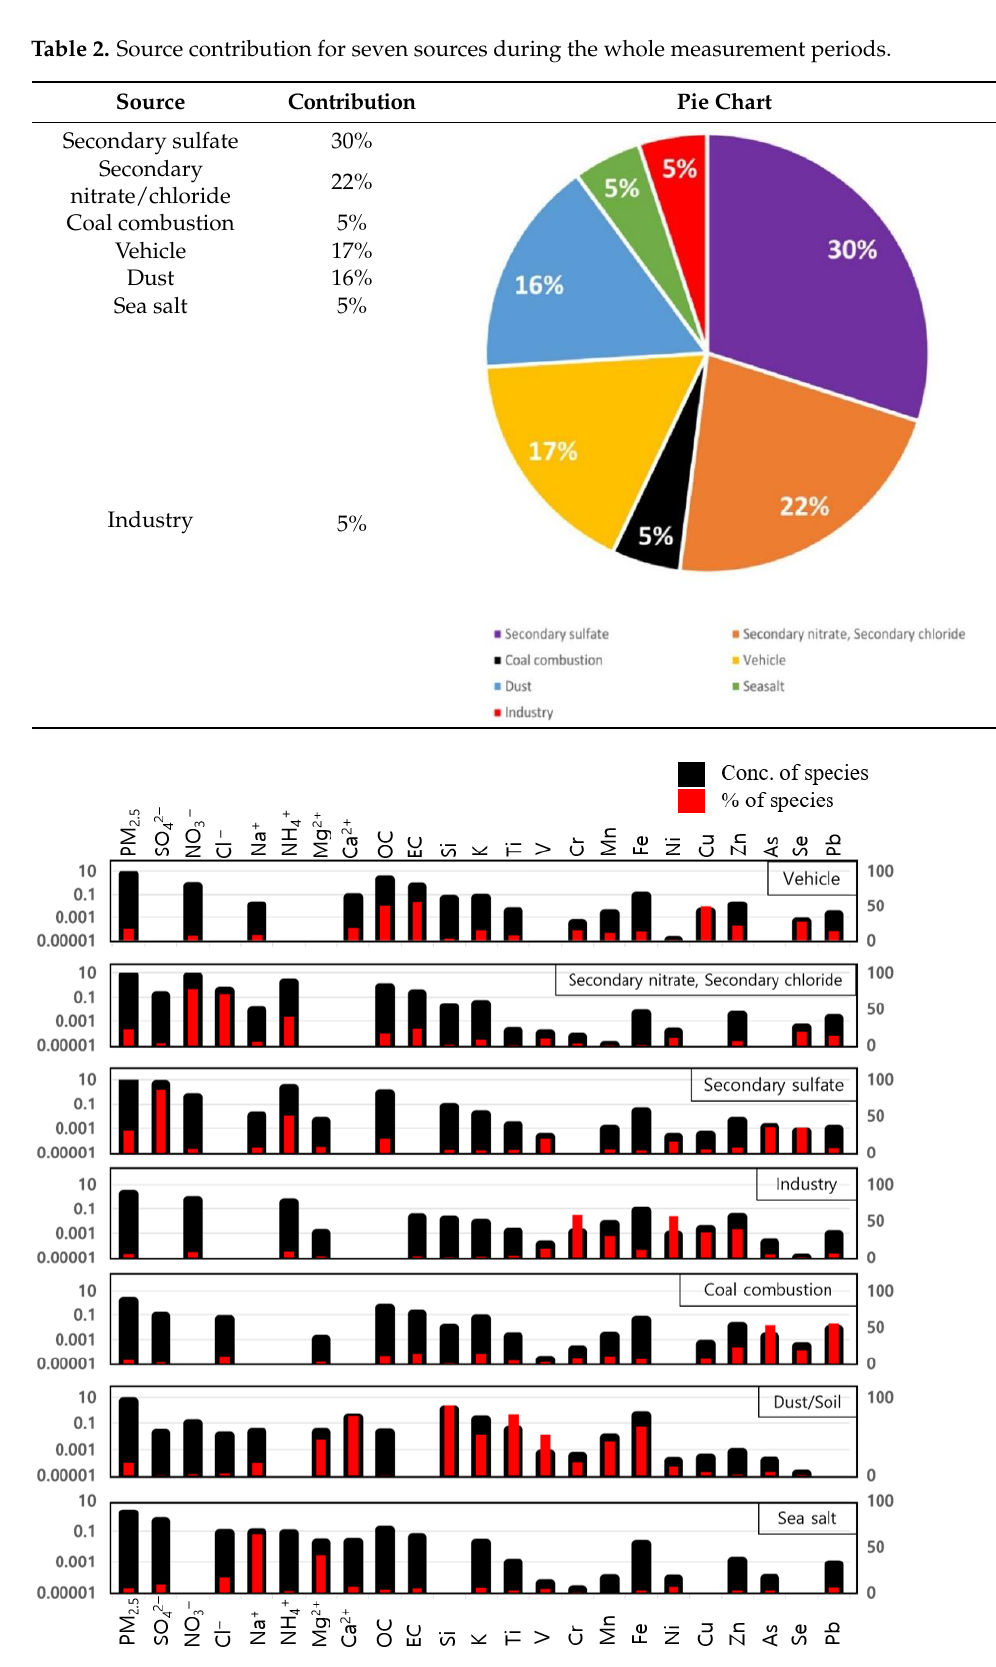
Figure 3. Factor profiles in Daejeon.